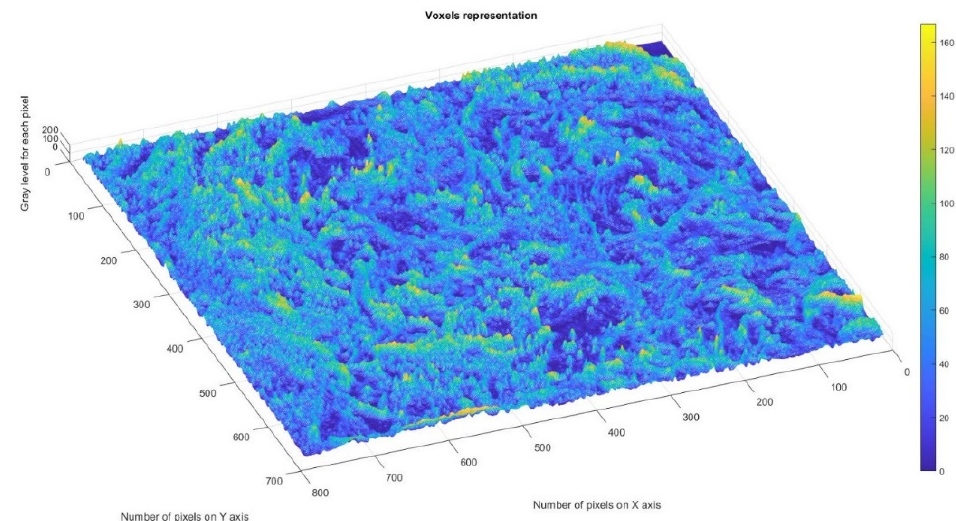
Figure 10. Three ‐ dimensional voxel representation of P 1 image. Figure 10. Three-dimensional voxel representation of P 1 image.